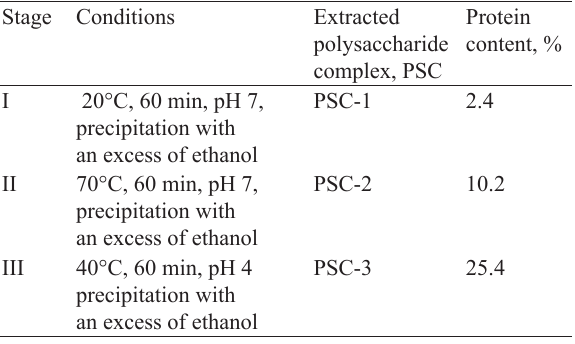
Protein polysaccharide